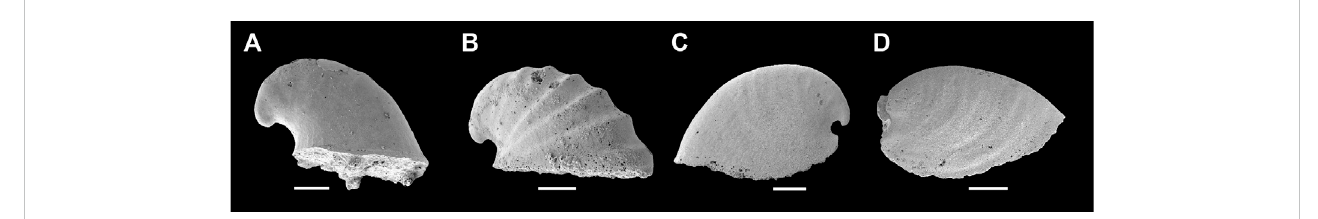
FIGURE 2 Representative members of Cambrian univalve molluscs from the Yanjiahe Formation. (A) Igorella emeiensis , internal mold, CUbar58-21. (B) I. maidipingensis , internal mold, CUBar119-4. (C) A. plana , internal mold, CUbar246-4. (D) Watsonella crosbyi , internal mold, CUBar186-6. (A,B,D) from the Member 5 of the Yanjiahe Formation in Yanjiahe section. (C) From the Member 5 of the Yanjiahe Formation in Gunziao section. Scale bars: 500 μ